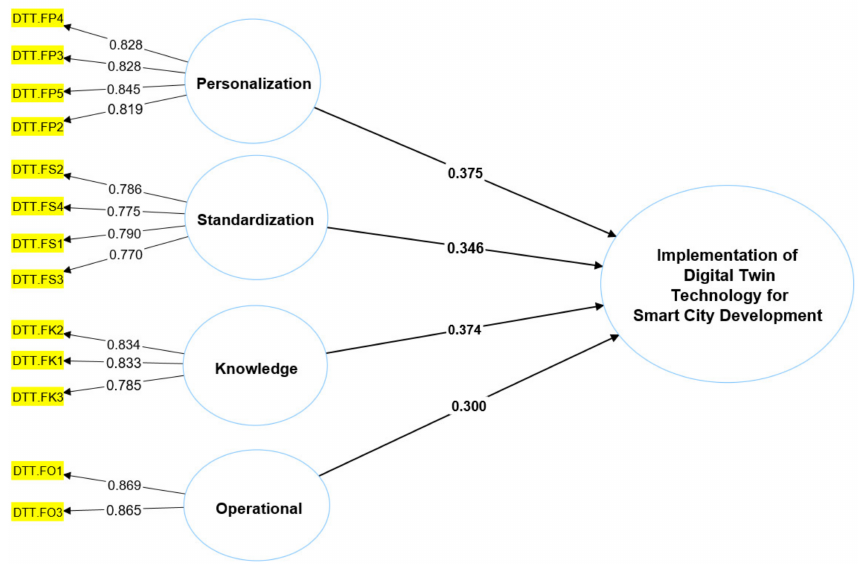
Figure 4. Structural model with path coefficients. Table 6. Construct validity and